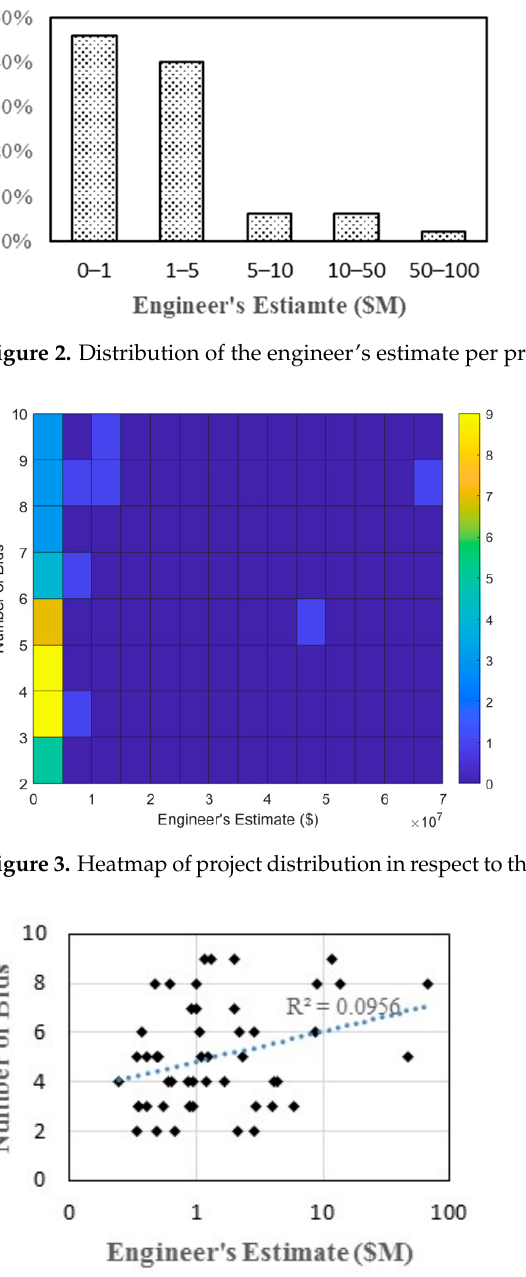
Figure 4. Distribution of the number of bids per engineer’s estimate.